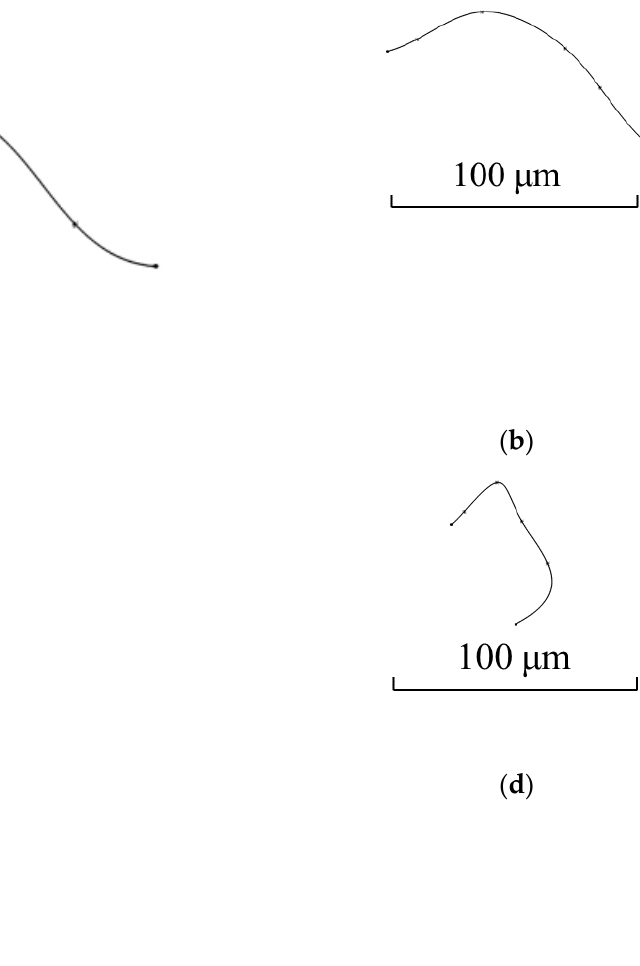
Figure 9. Splines passing through the centers of the models of grain before ( a ) and after ( b ) screw rolling.